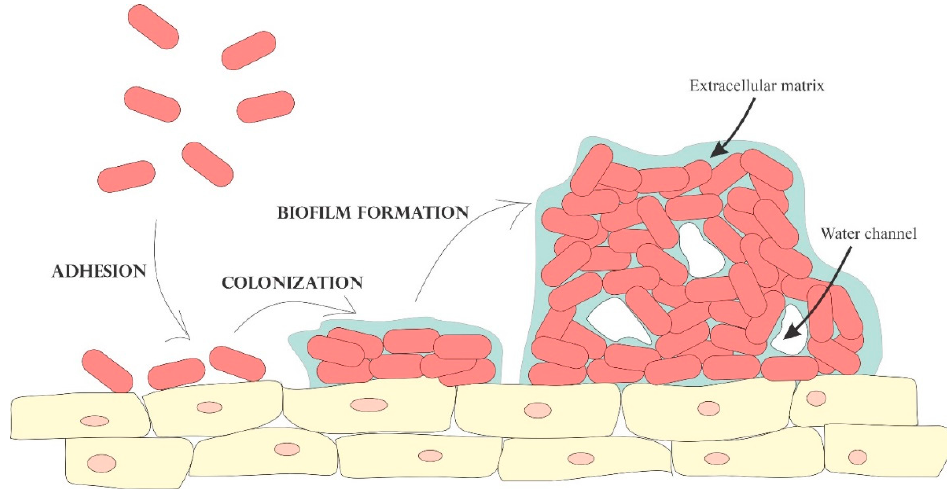
Figure 2. Schematic illustration of biofilm formation.